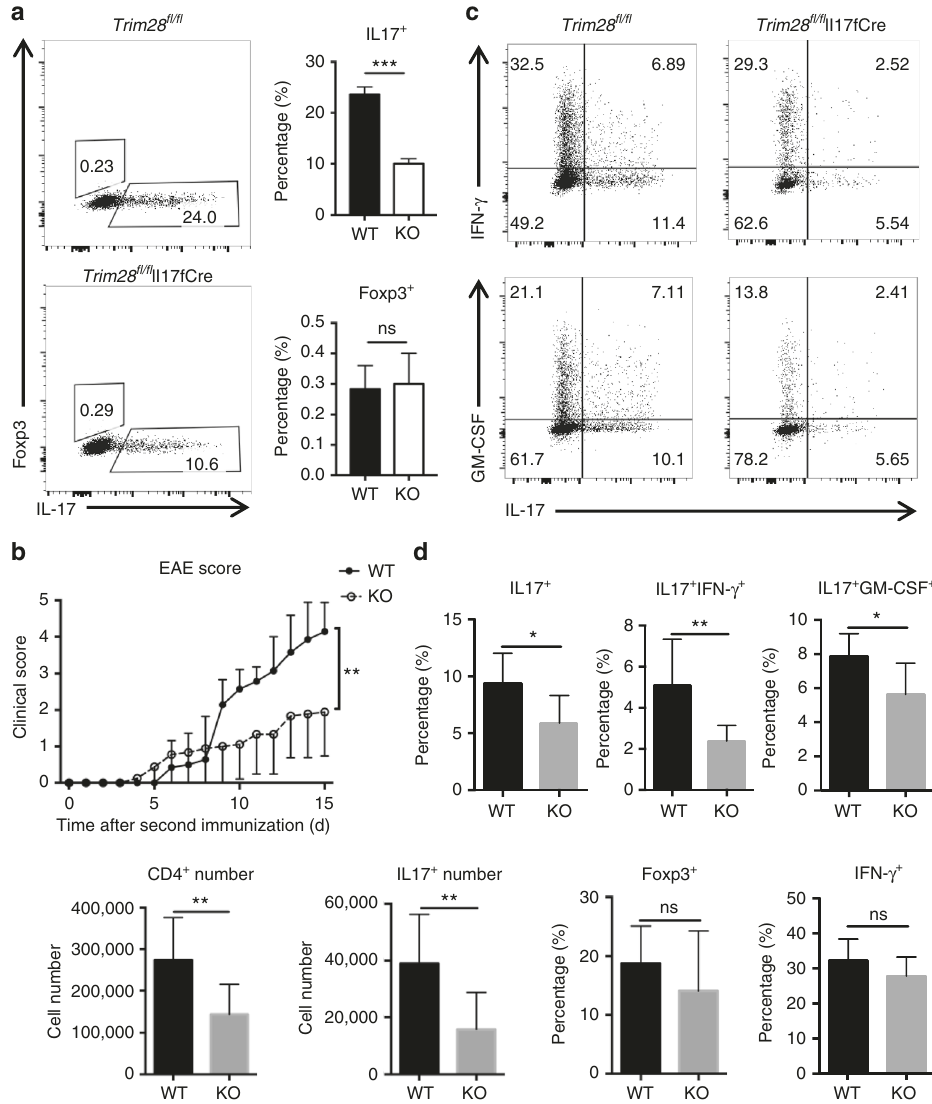
Fig. 3 Th17-speci fi c deletion of TRIM28 resulted in defective Th17 differentiation and resistance to EAE. a Naive T cells isolated from WT and Trim28 fl / fl Il17fcre mice were differentiated into Th17 cells under TGF- β plus IL-6 condition for 3 days, then re-stimulated for cytokine staining, and Student ’ s t test was used for the statistical test. b The disease scores of WT and Trim28 fl / fl Il17fcre mice in EAE, and two-way ANOVA was used for the statistical test (WT: n = 7, Trim28 fl / fl Il17fcre: n = 7, two mice in WT group died before sacri fi ced); c Intracellular staining of IL-17, GM-CSF and IFN- γ of in fi ltrated CD4 + T cells in the central nerve system (CNS) of EAE mice. d Cellularities and percentages of CNS-in fi ltrating cells, and Student ’ s t test was used for the statistical test. ns = not signi fi cant; * p < 0.05, ** p < 0.01, *** p < 0.005. All error bars represent SDs. The data are a representative for three independent